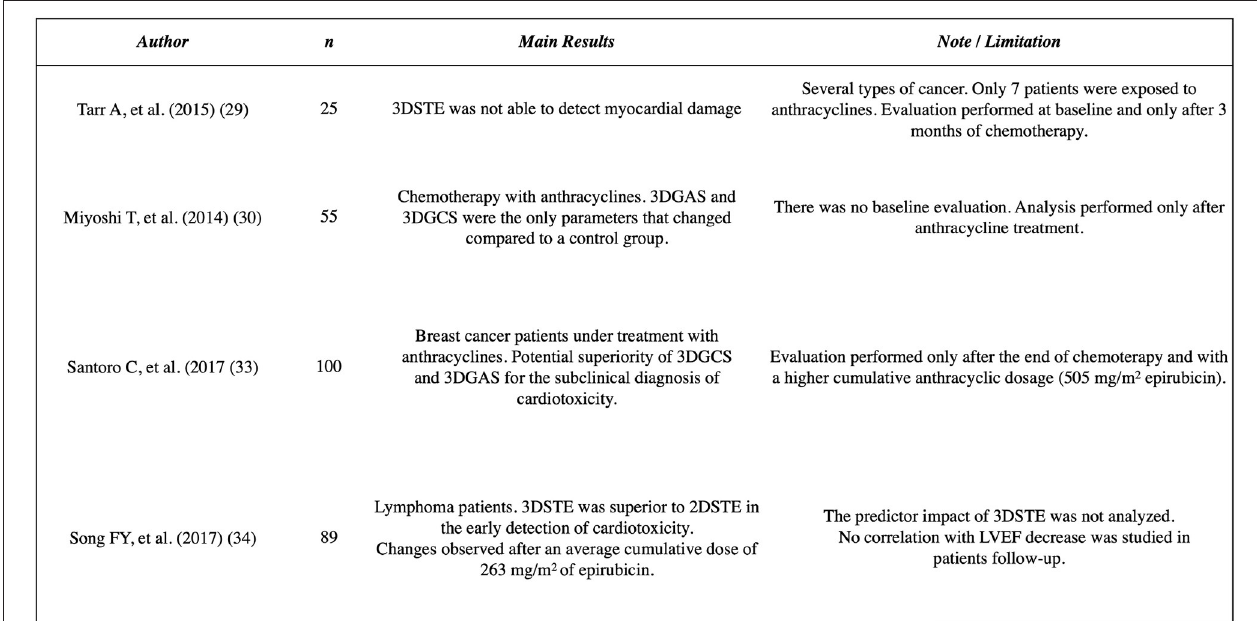
FIGURE 6 | Studies reporting the 3D speckle tracking echocardiography analysis in cancer patients undergoing chemotherapy. GAS, global area strain; GCS, global circumferential strain; LVEF, Left ventricle ejection fraction. STE, speckle tracking